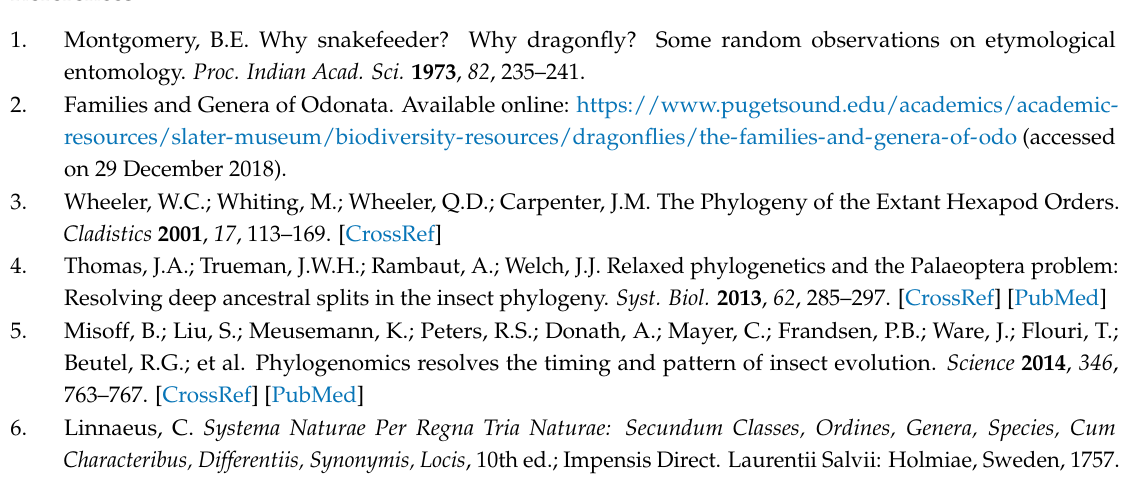
Figure S1: The most recent extensive phylogeny of suborder Zygoptera; Figure S2: The most recent extensive phylogeny of the suborder